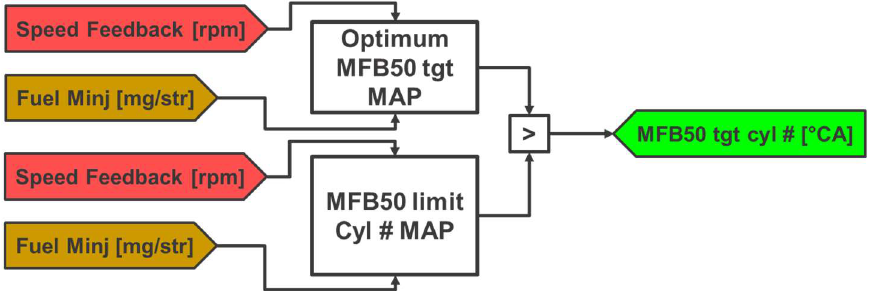
Figure 7. Block diagram for the determination of MFB50 target in the default state. During the learning state, the MFB50 target value for each cylinder is evaluated using the schematic in Figure 10.